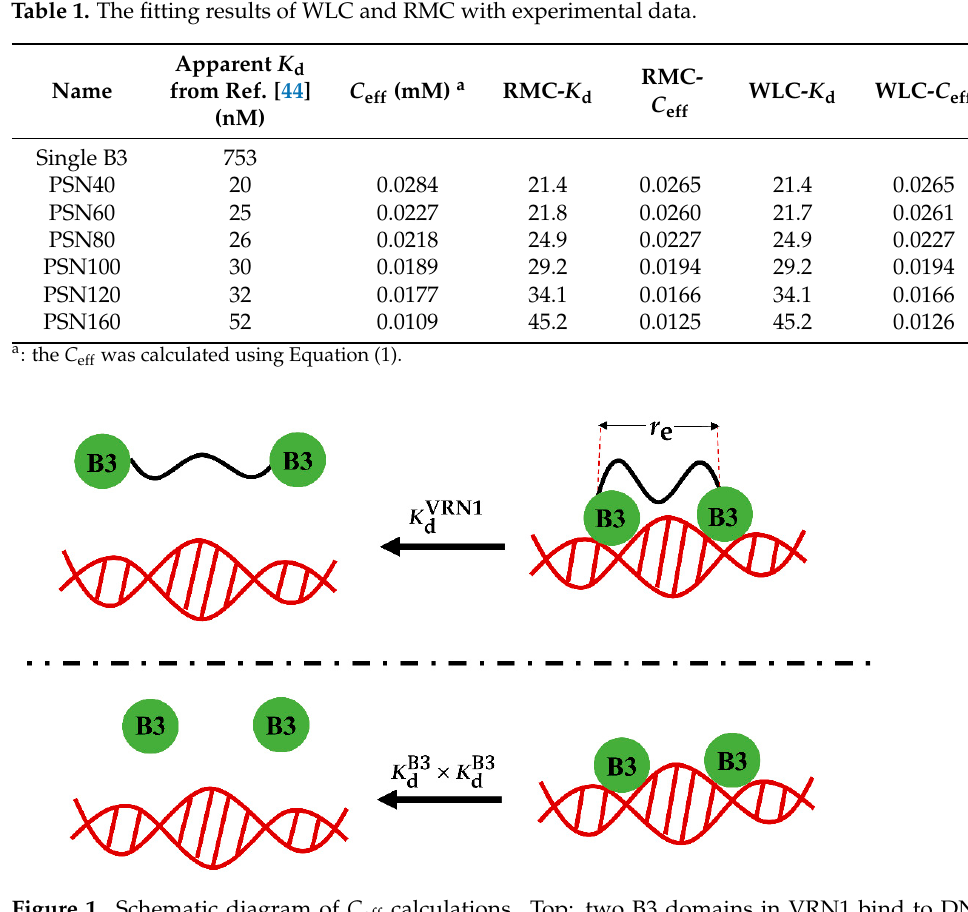
. r e denotes the d × K B3 . The linker in d d